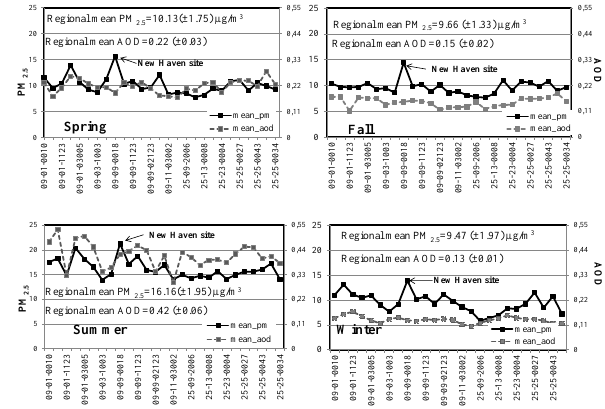
Fig. 10. Seasonal trend of average AOD and average PM 2 . 5 for rep- resentative monitoring EPA sites located in MA and CT using all available MAIAC